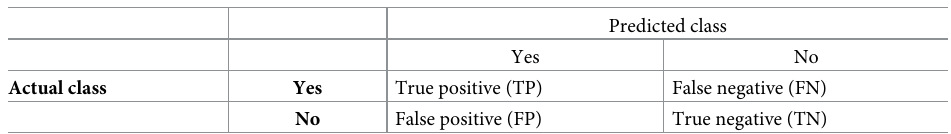
Table 2. Confusion